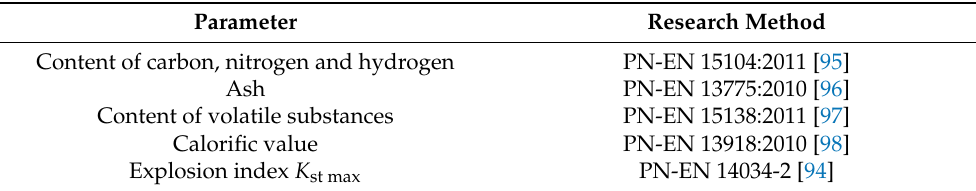
Table 2. Analyzed properties and research methods